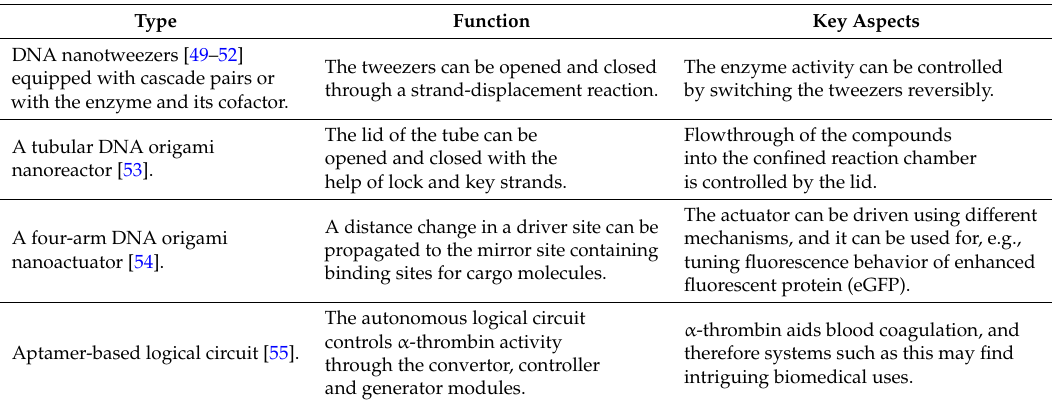
Table 2. Examples of mechanical regulatory DNA-enzyme